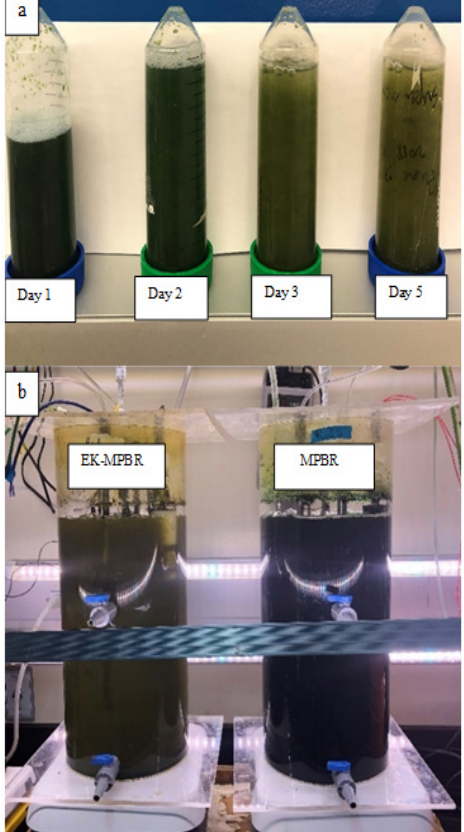
Figure 6. The color of microalgae grown in ( a ) EK-MPBR from day 1 to day 5 and ( b ) EK-MPBR and MPBR at day 20.